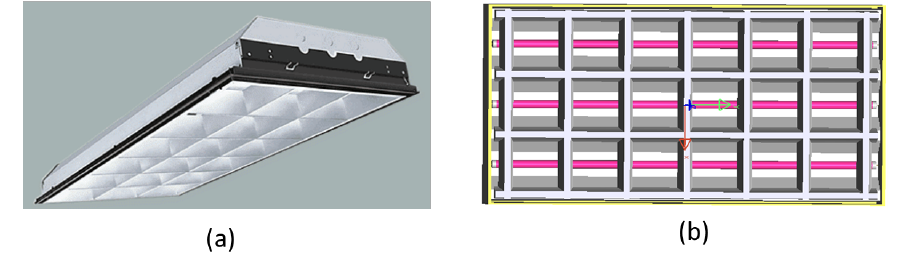
Figure 12. ( a ) A compact fluorescent lamp with a V-shaped louver and ( b ) a fluorescent light model built with LightTools software.